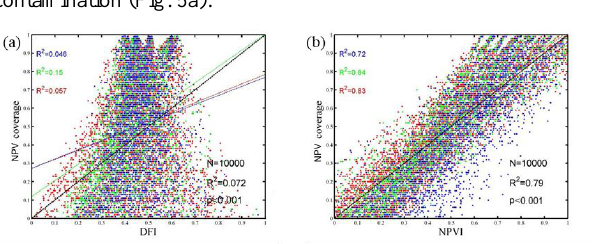
Fig.5 Relationship between NPV coverage and (a) DFI and (b) NPVI for the simulated data. Red, green and blue represent the different soil moisture ranging from 2.43% to 25.78%